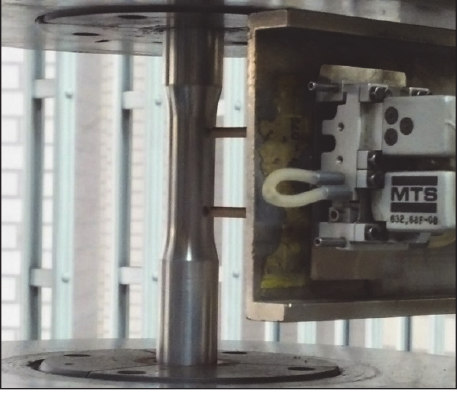
Figure 4: Tension-torsion testing machine and extensometer mounted on a tubular specimen.